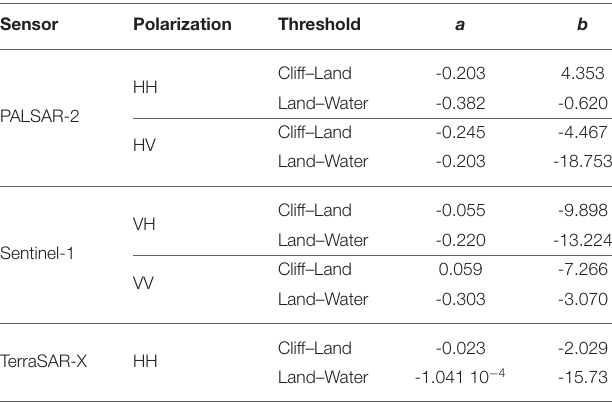
TABLE 3 | Threshold parameters for each satellite and polarization. Sensor